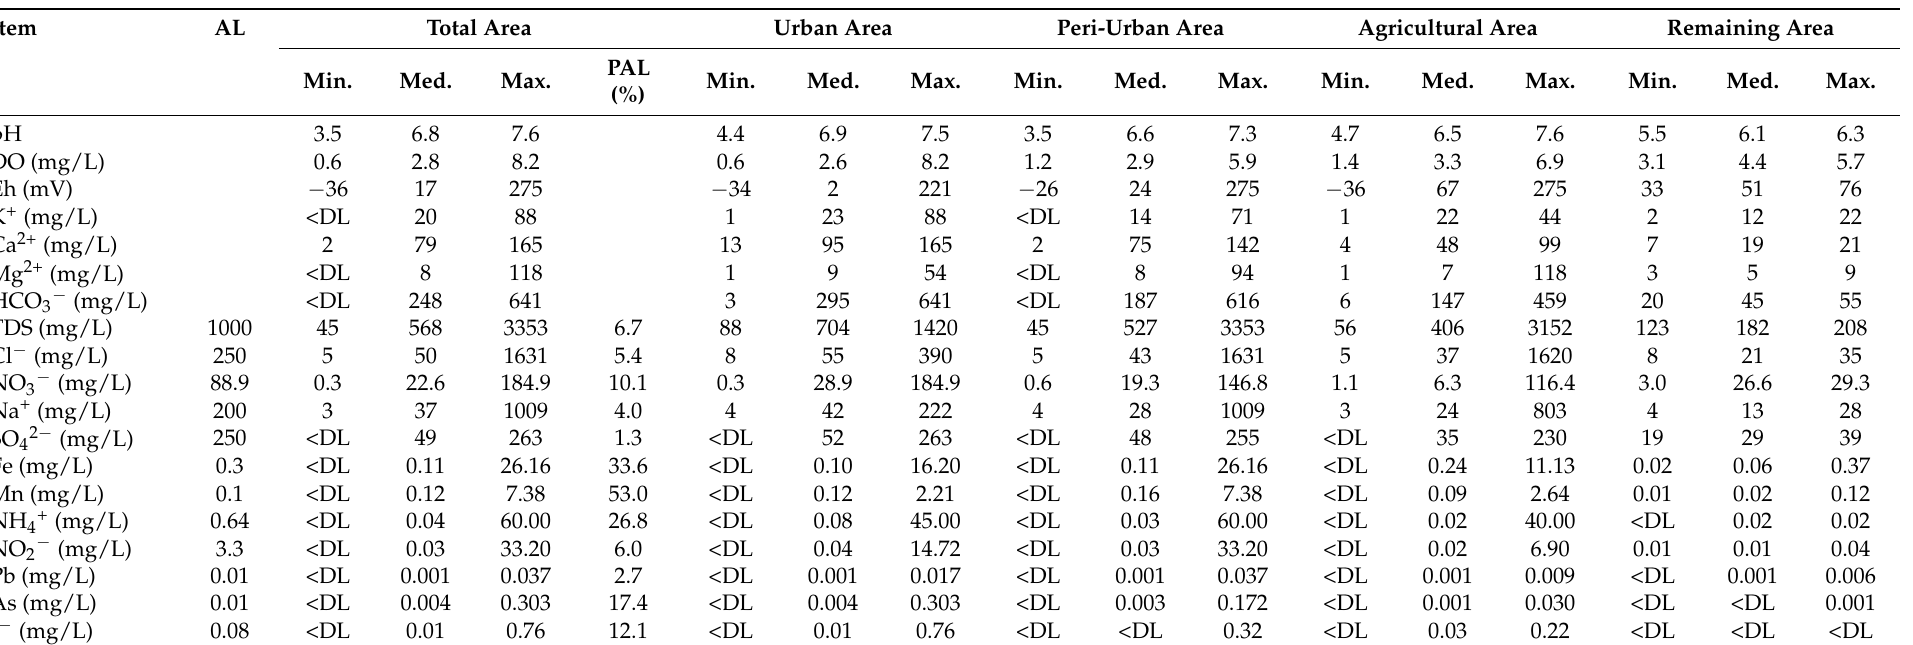
Table 1. Descriptive statistics of concentrations of chemical parameters in groundwater of the coastal alluvial aquifer in the Pearl River